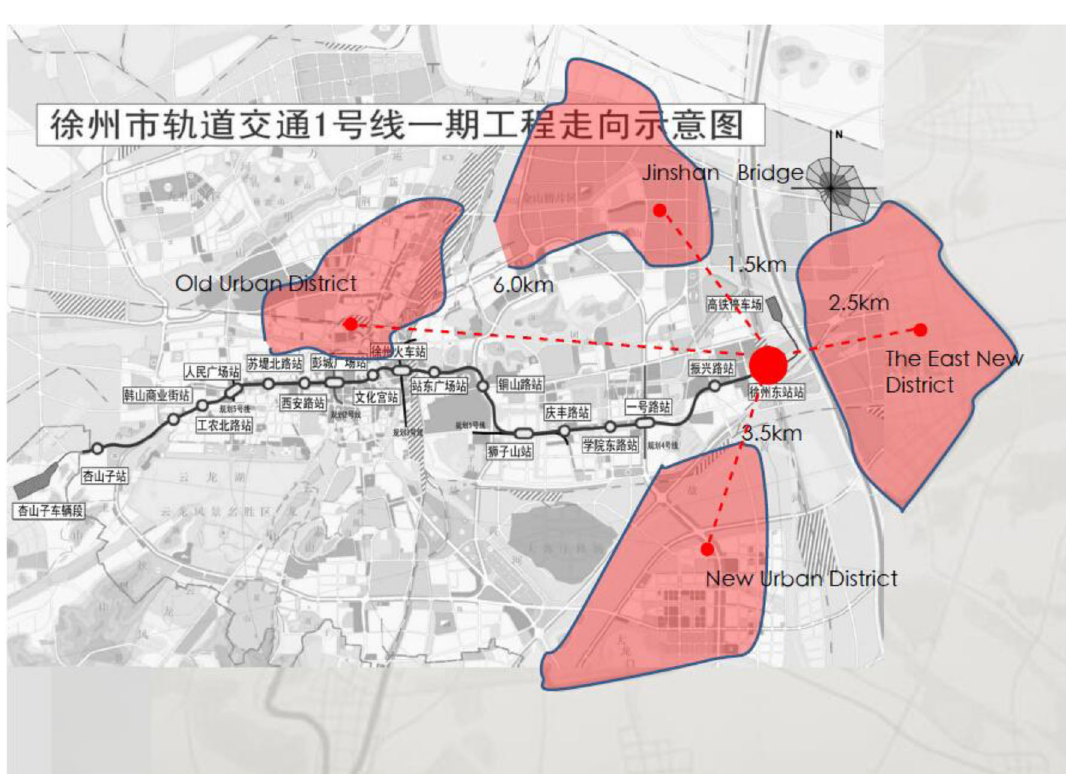
Fig. 2 Metro line 1 and the high-speed railway station